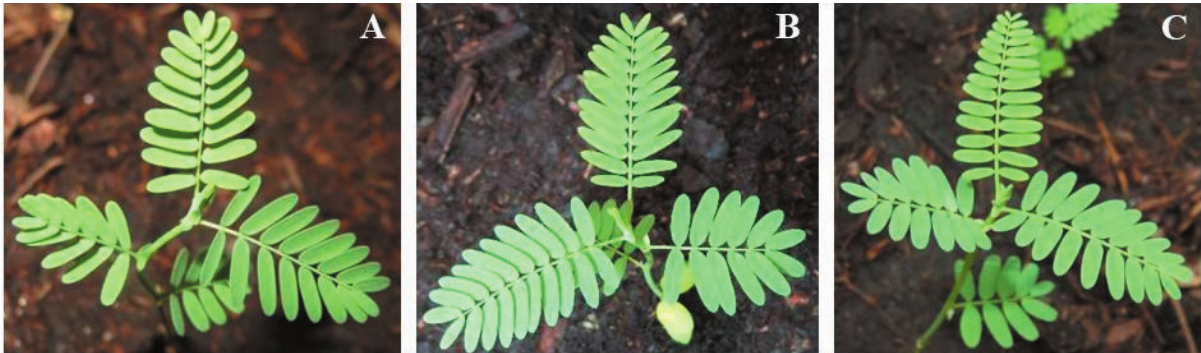
Figure 2. Seedling morphology of Aeschynomene under study until the complete development of the fourth eophyll A , Aeschynomene eve- nia ; B , A. scabra ; C, hybrid of Aeschynomene .